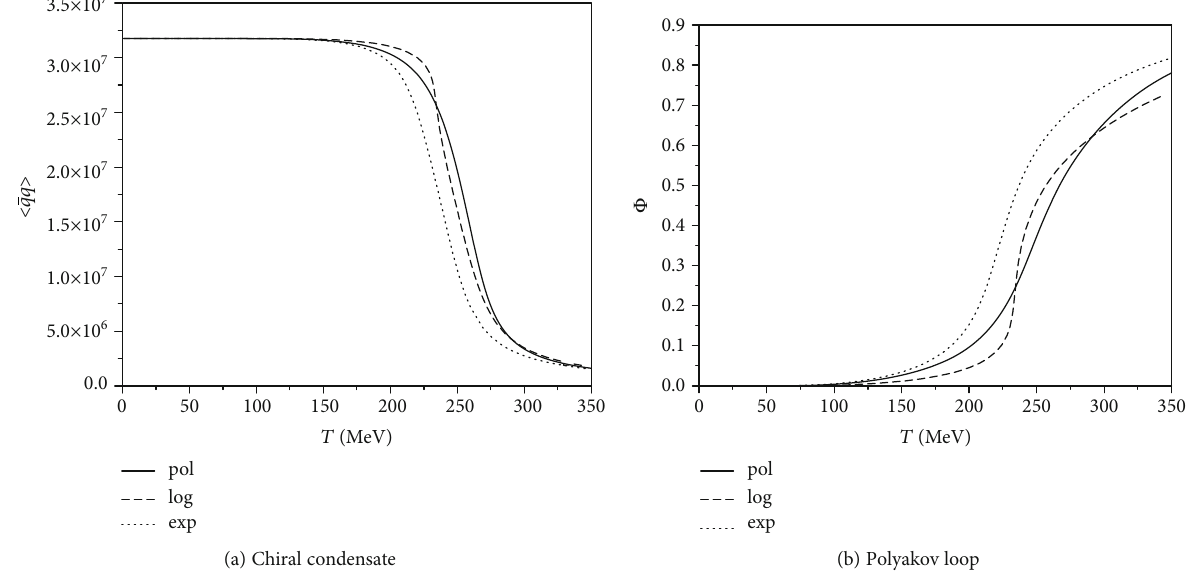
Figure 1: Order parameter as a function of temperature at μ = 0